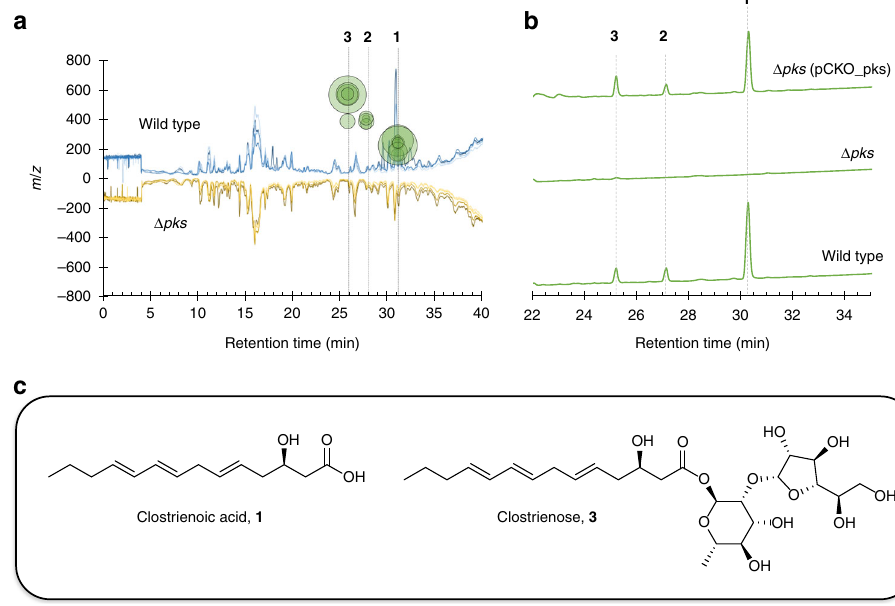
Fig. 1 Identi fi cation of polyketides from wild-type extracts. a Results of XCMS analysis of wild-type C. acetobutylicum and Δ pks extracts taken from early stationary phase fermentation cultures (biological quadruplicates). Blue (upper) chromatograms depict MS traces of quadruplicate wild-type extracts, while orange/brown (lower) chromatograms depict MS traces of quadruplicate Δ pks extracts. Green circles represent MS peaks unique to wild-type extracts, with corresponding m/z values indicated by the y -axis. No signi fi cant MS peaks were identi fi ed, which were unique to Δ pks . The three peaks unique to wild type are identi fi ed as 1 , 2 , and 3 . b UV – Vis traces (240 nm) of extracts from wild type, Δ pks , and Δ pks genetic complementation strain ( Δ pks (pCKO_pks)). c Elucidated structures of 1 and 3 based on NMR